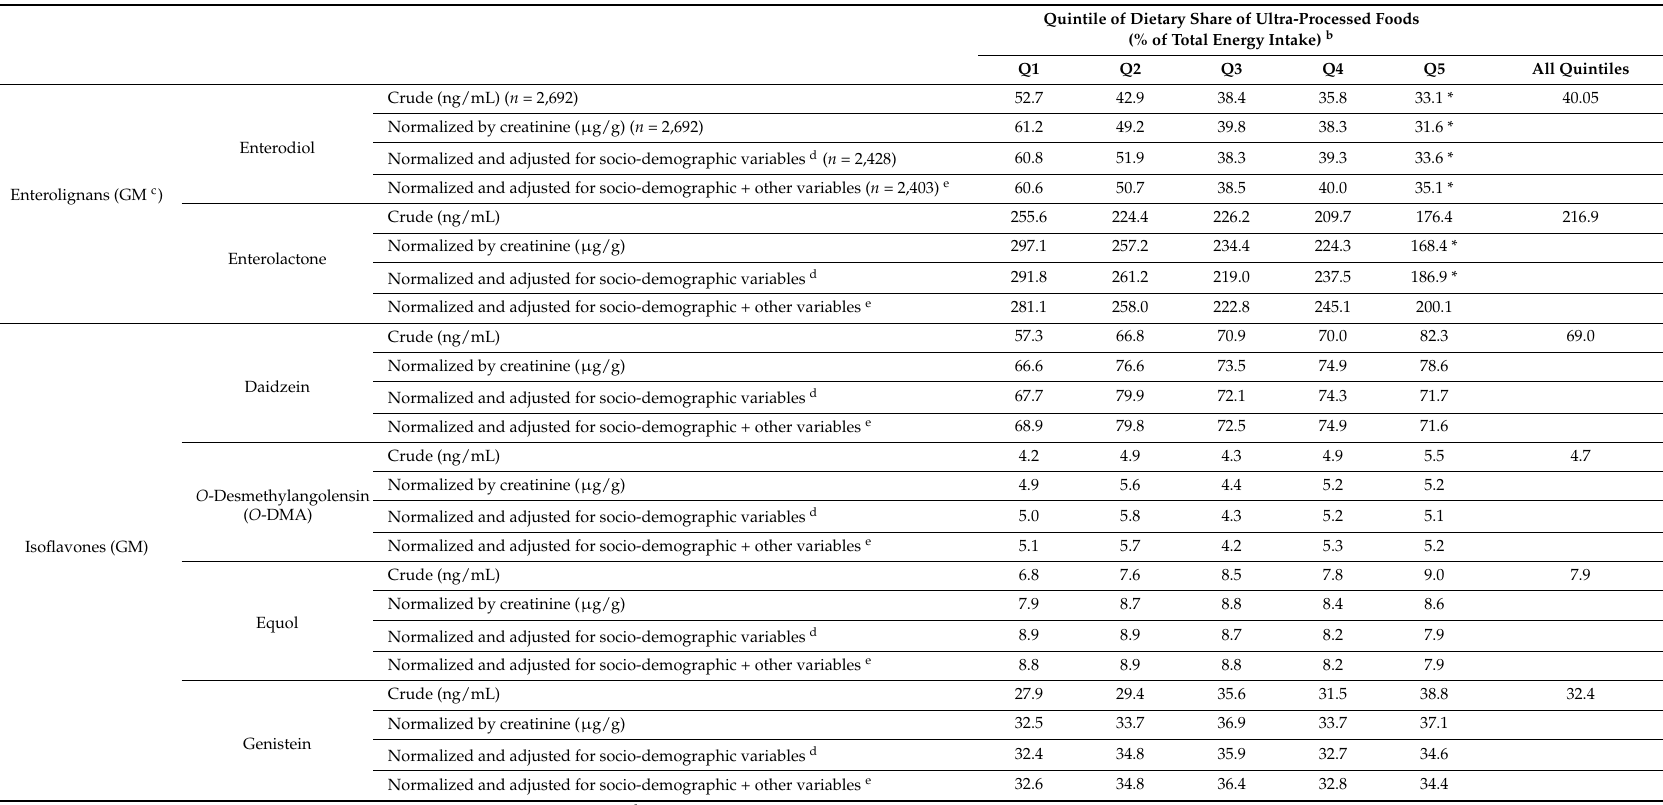
Table 2. Phyto-estrogen concentrations according to the quintiles of the dietary share of ultra-processed foods a